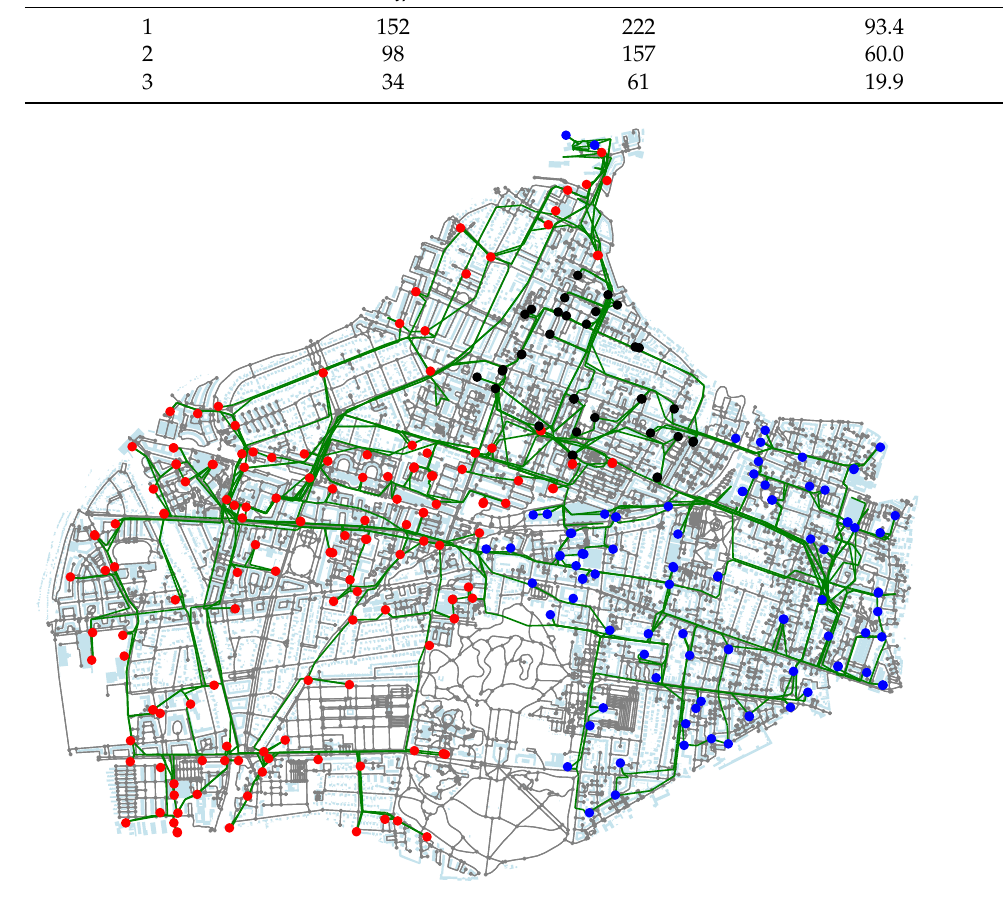
Figure 2. Visualization of the urban power distribution network of Frederiksberg. The grid topology is shown on the footprint of the municipality, with gray lines indicating roads and walking paths and buildings represented in light blue. The 10/0.4 kV transformers i = {1, 2, 3} are illustrated by red, blue, and black solid dots. Medium voltage underground cables for all PDNs are shown in